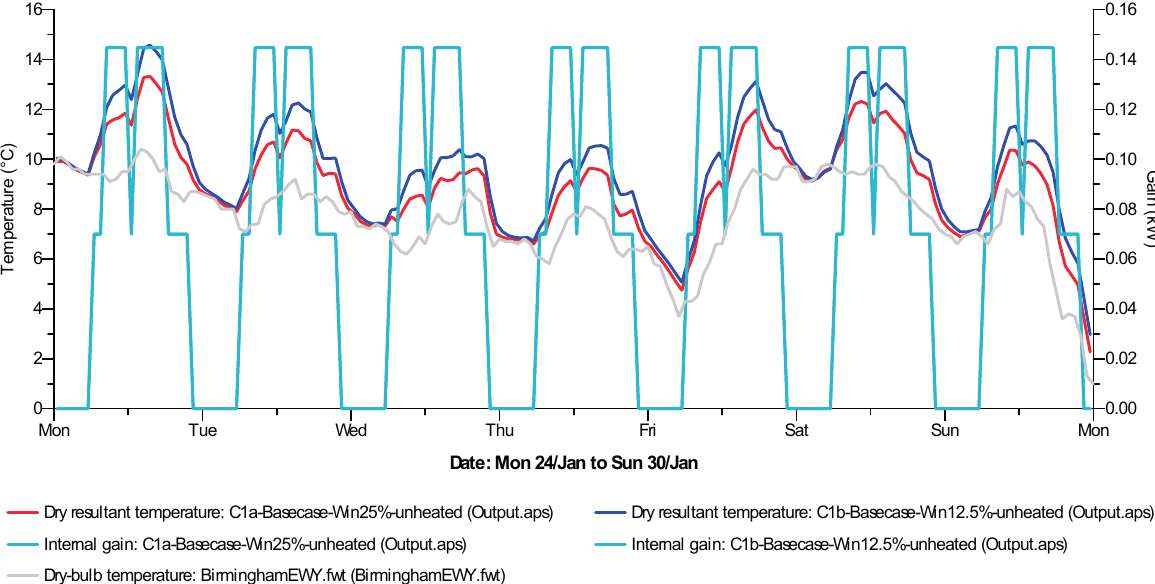
Figure 6. Predicted (typical January weekly) indoor temperature and internal gains for unheated base